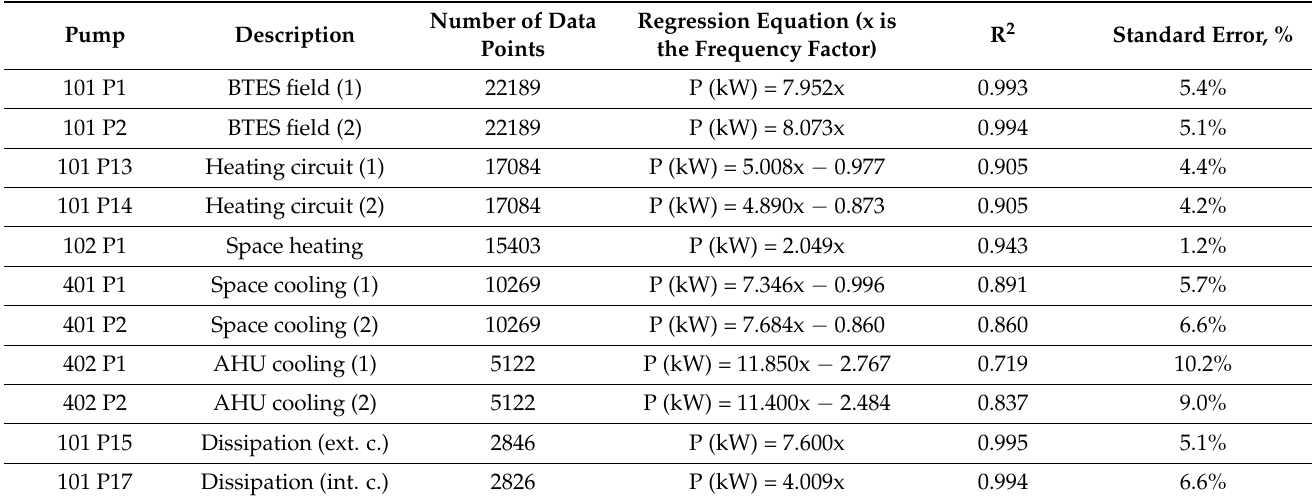
Table 3. HVAC pumps: parameters for linear regression models and accuracy.